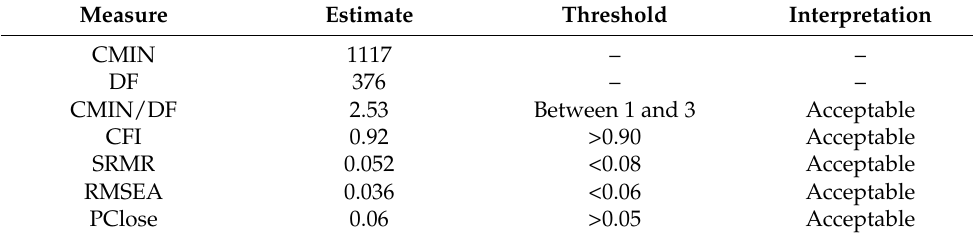
Table 3. Model Fit.